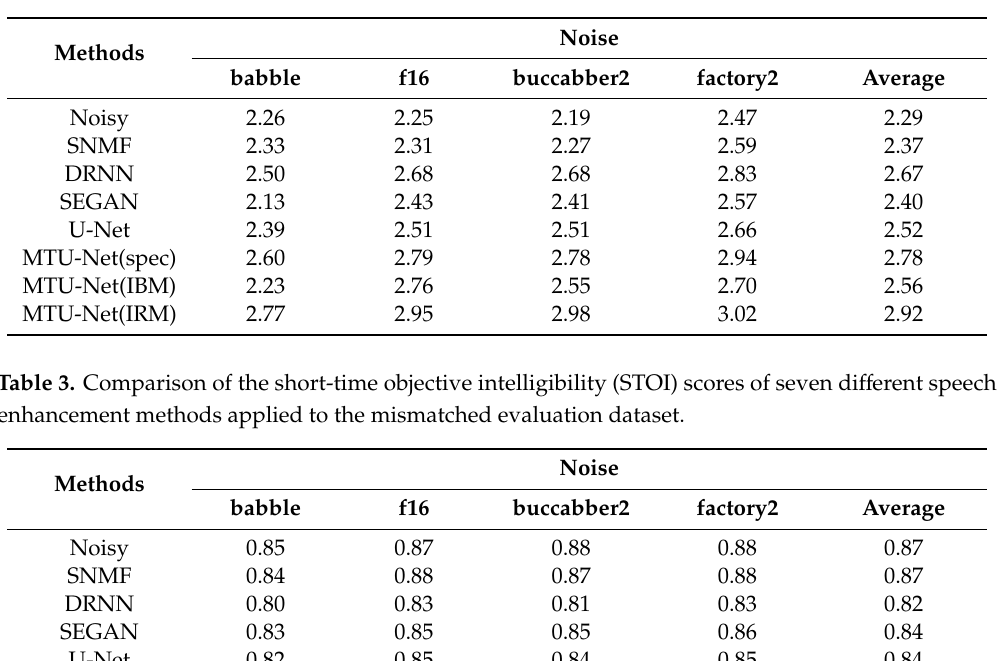
Table 2. Comparison of the perceptual evaluation of speech quality (PESQ) scores of seven di ff erent speech enhancement methods applied to the mismatched evaluation dataset.